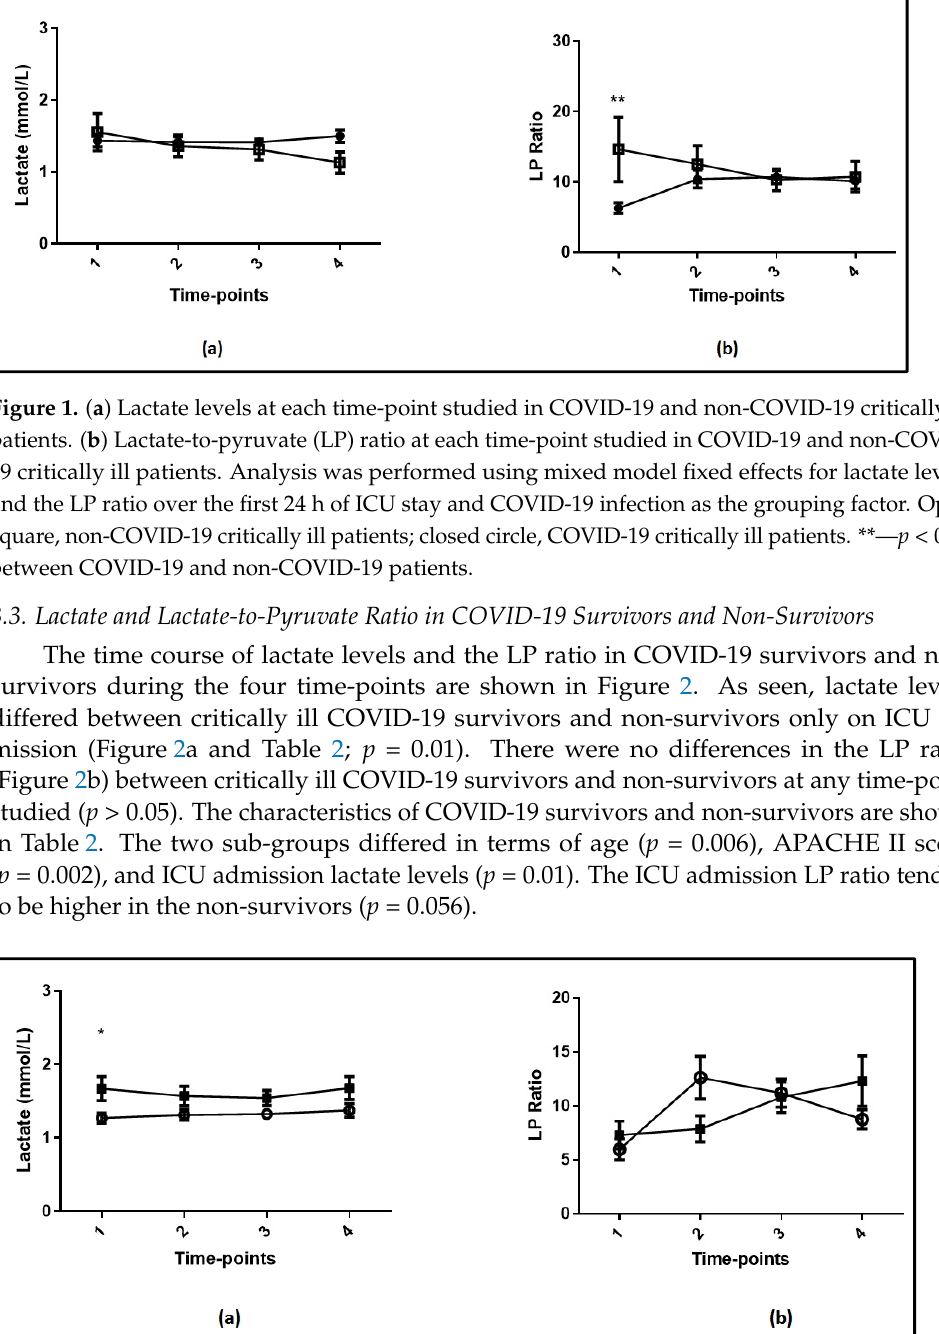
Figure 2. ( a ) Lactate levels at each time-point studied in COVID-19 survivors and non-survivors. ( b ) Lactate-to-pyruvate (LP) ratio at each time-point studied in COVID-19 survivors and non-survivors. Analysis was performed using mixed model fixed effects for lactate levels and the LP ratio over the first 24 h of ICU stay and ICU mortality as the grouping factor. Open circle, COVID-19 survivors; closed square, COVID-19 non-survivors. *— p < 0.05 between survivors and non-survivors.